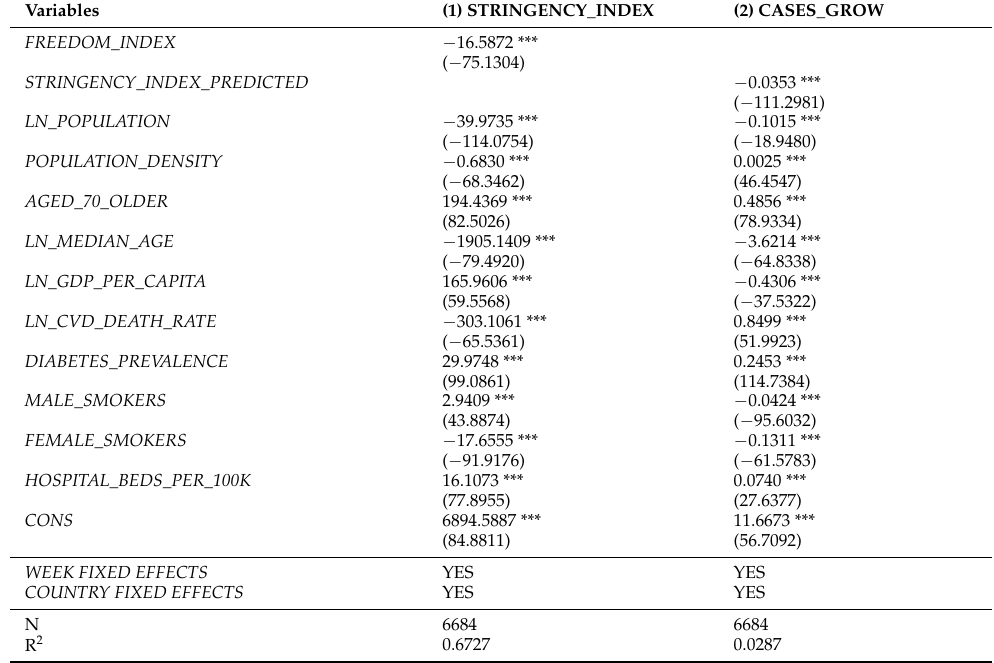
Table 6. Endogeneity check using the country Freedom in the World Index as an instrumental variable.